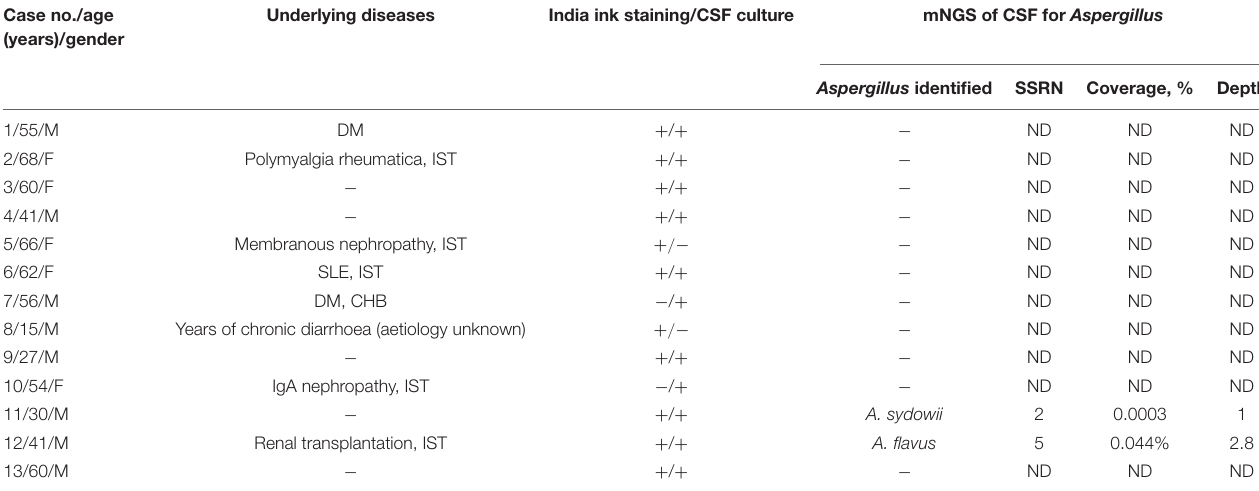
TABLE 2 | Characteristics of 13 patients with cryptococcal meningitis.